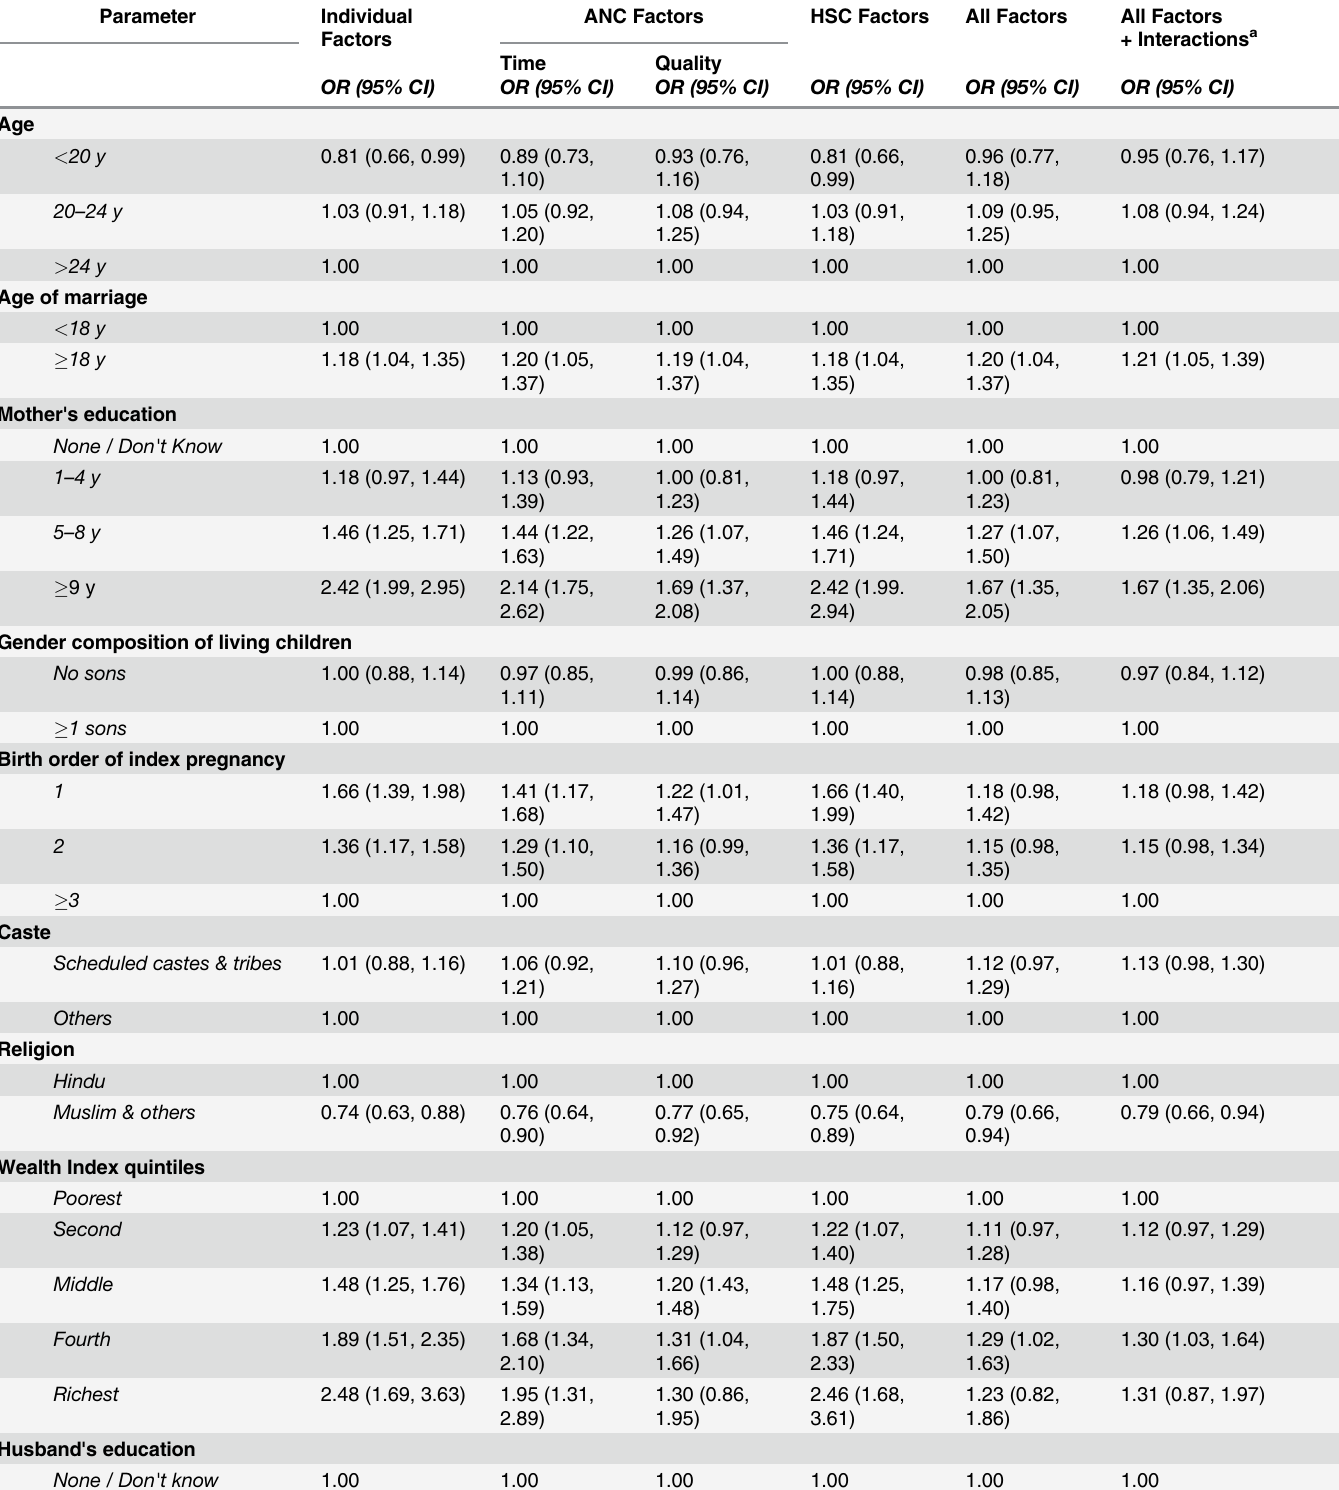
Table 6. Multilevel modeling of any iron and folic acid receipt during last